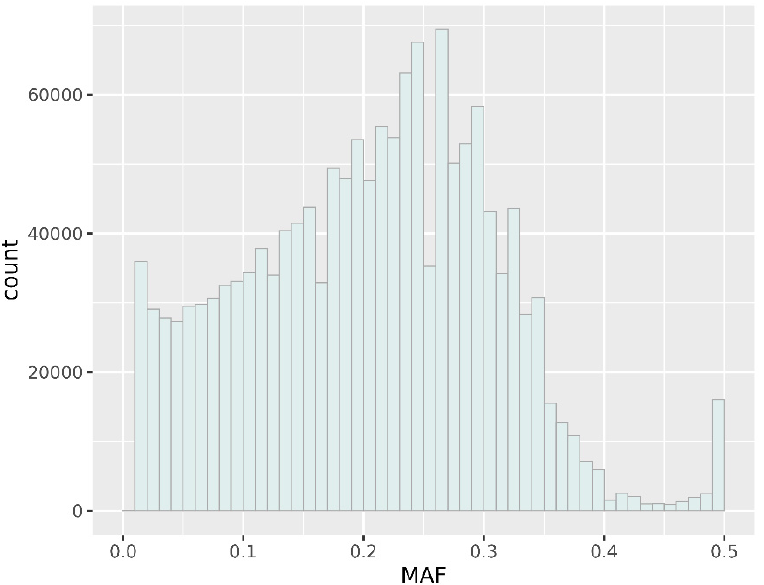
Figure 1. The minor allele frequency distribution for 1,508,407 SNPs in the Lithuanian population samples.